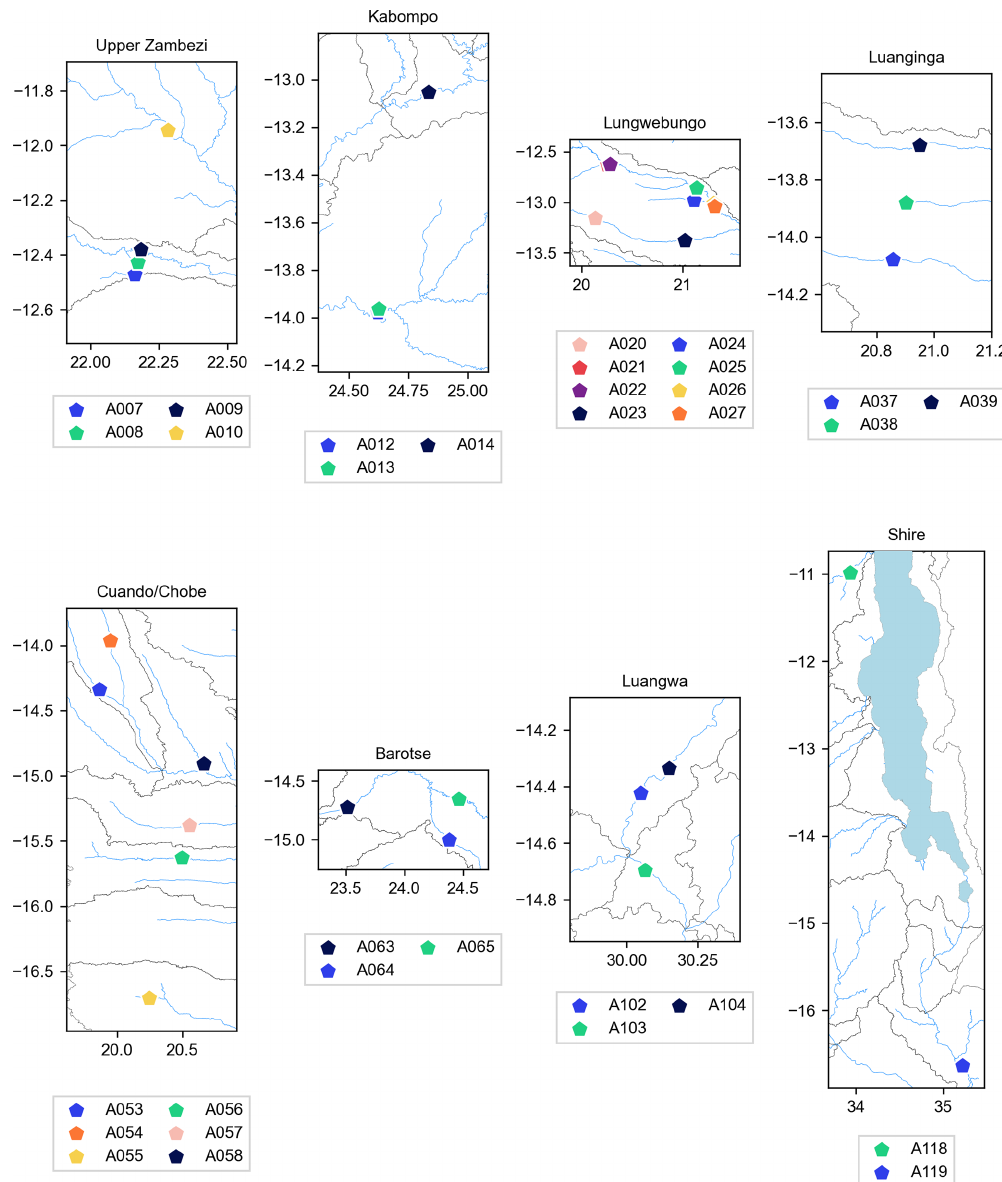
Figure A3. Sentinel-3A VSs improved by the OLTC update in the GPOD and SciHub datasets.